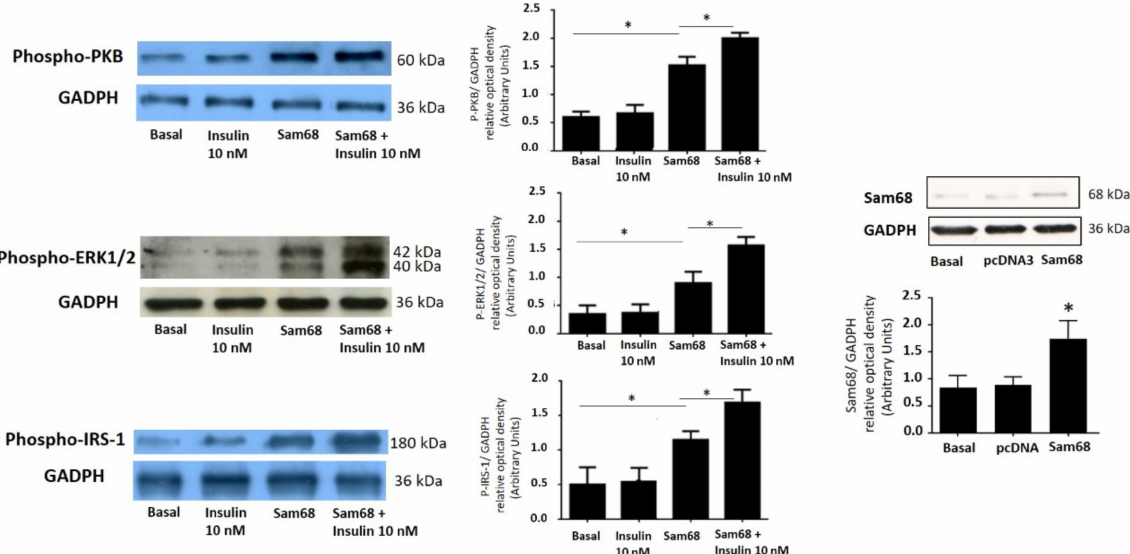
Figure 5. Sam68 overexpression increases the insulin-dependent activation of PI3K and MAPK path- ways in human GCs from women with PCOS. GCs were transfected with Sam68 plasmid, as described in Section 2, and incubated in absence or presence of insulin 10 nM for 10 min. GC lysates were separated by SDS-PAGE, and Western blot analysis was performed by using anti-P-IRS-1, anti-P-PKB, and anti-P-ERK1/2 antibodies to study insulin activation of the PI3K and MAPK signaling pathways. Sample protein loading was controlled by using anti-GAPDH antibodies. Control of transfection of Sam68 is shown by using pcDNA3 plasmid with or without Sam68 cDNA as control in human GCs from PCOS. We show the corresponding densitometric analysis of three independent experiments as means ± SD. Statistical analyses were performed by ANOVA. Asterisks indicate significant differences from the control according to Bonferroni’s multiple comparison post-hoc test Sam68 expression was confirmed by immunoblot of cell lysates of granulosa cells in the absence and presence of 10 nM insulin for 24 h, using anti-Sam68 antibodies and anti-GAPDH as the loading